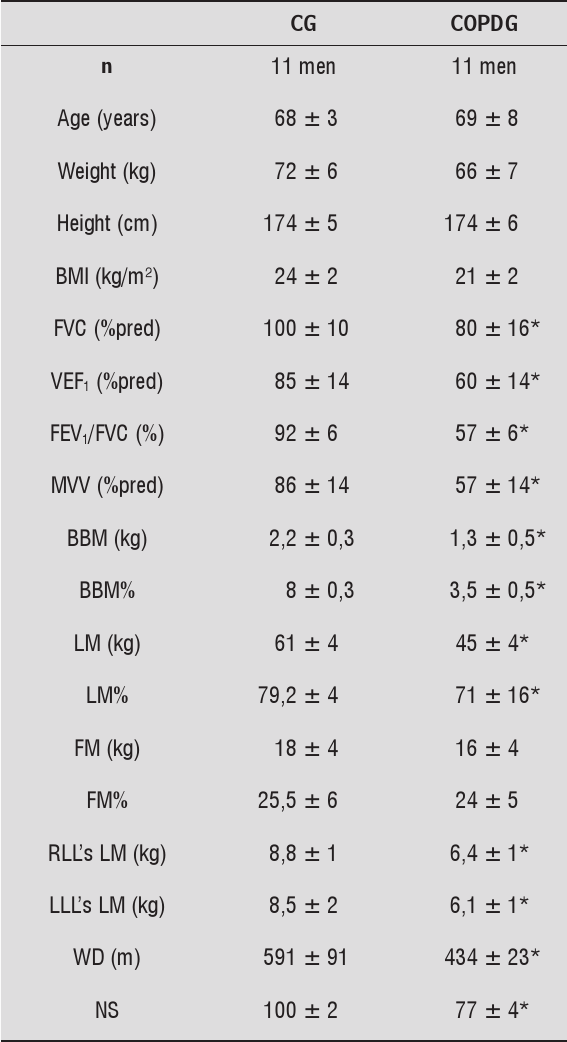
Table 1 - CG and COPDG anthropometric characteristics,